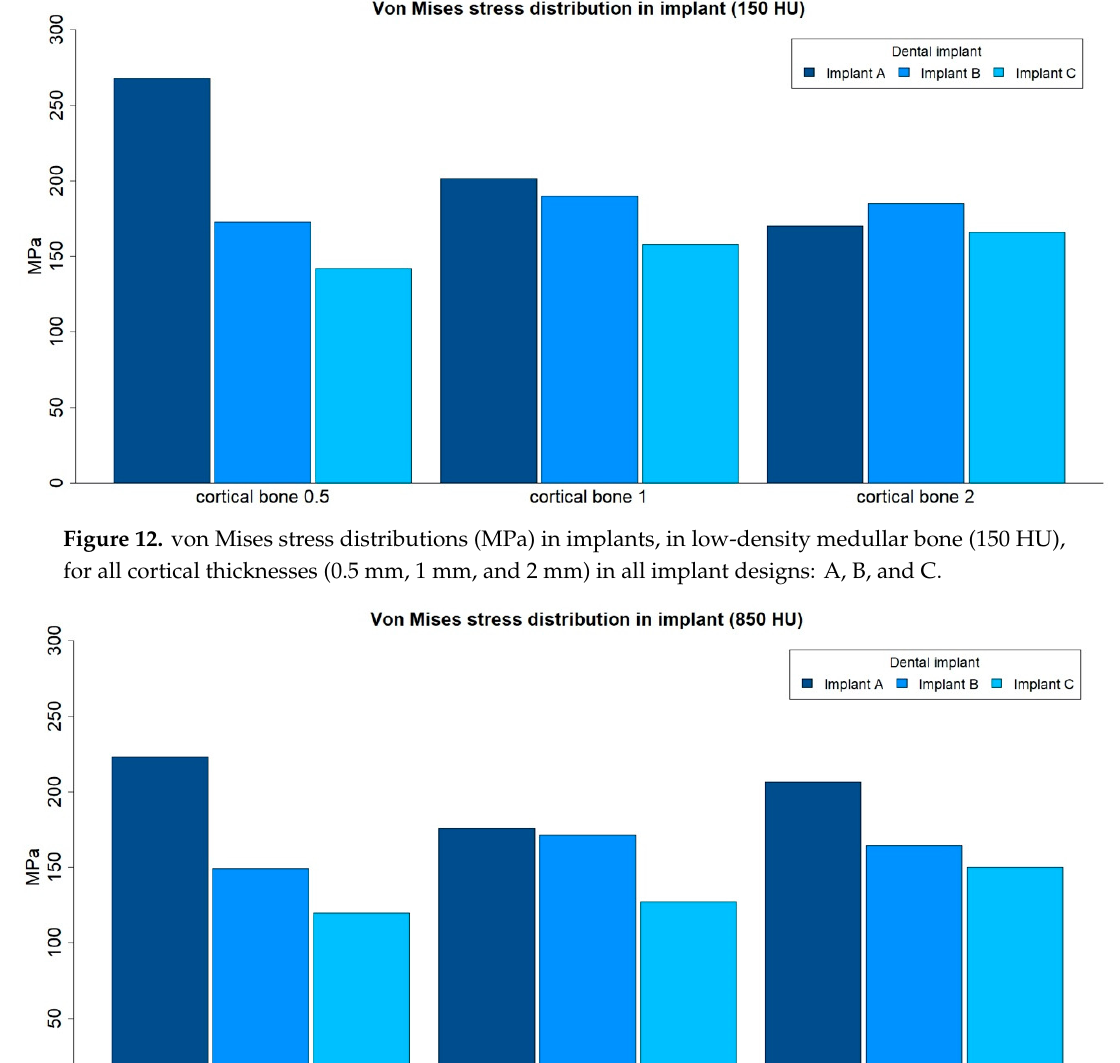
Figure 11. von Mises stress distributions in bone for all implant designs: A, B, and C. Note: the figure is in very high resolution to be able to be enlarged: enlarge it in your word processor or view it in HTML format.